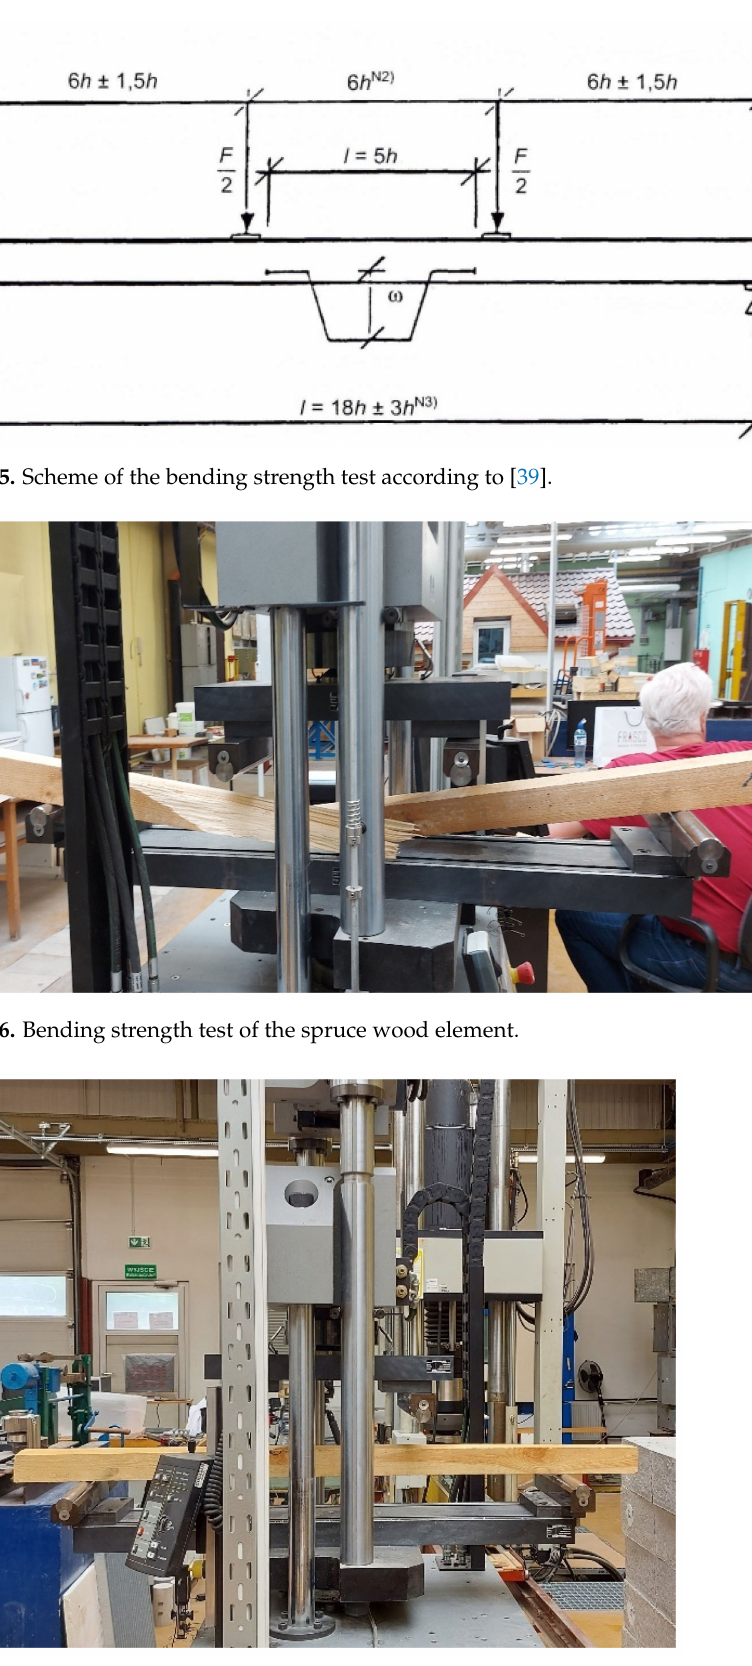
Figure 7. Bending strength test of the pine wood